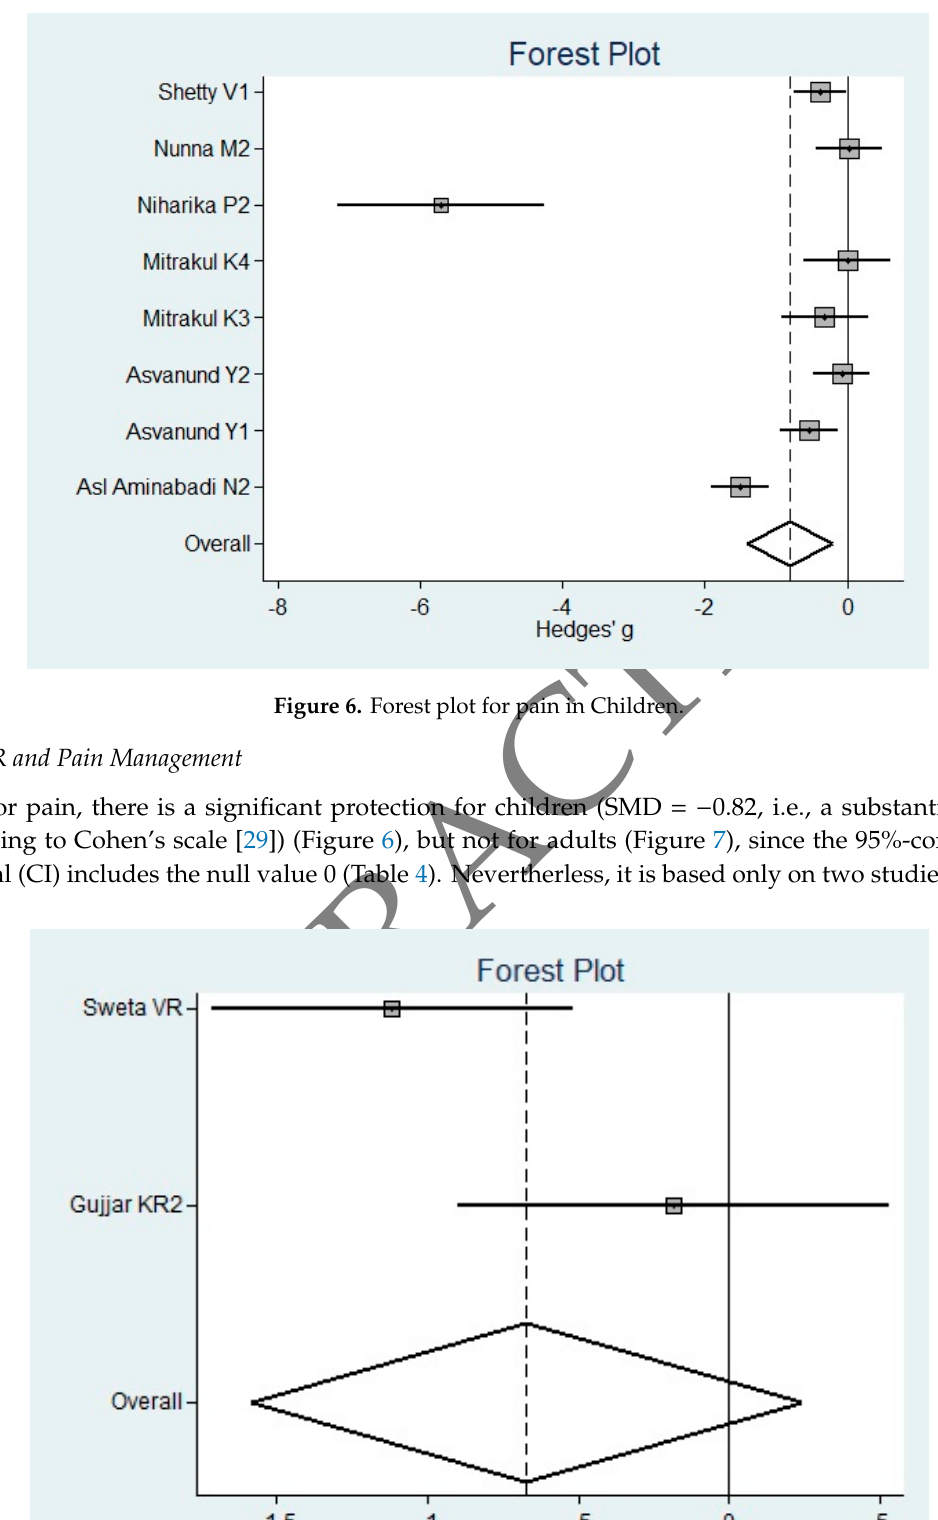
Figure 7. Forest plot for Pain in Adults.